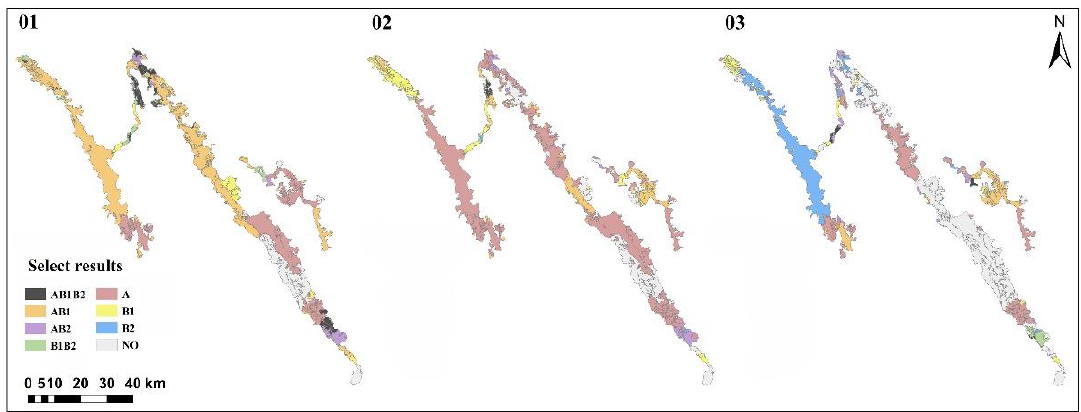
Figure 5. Landscape unit suitability maps for Zones A, B1, and B2.